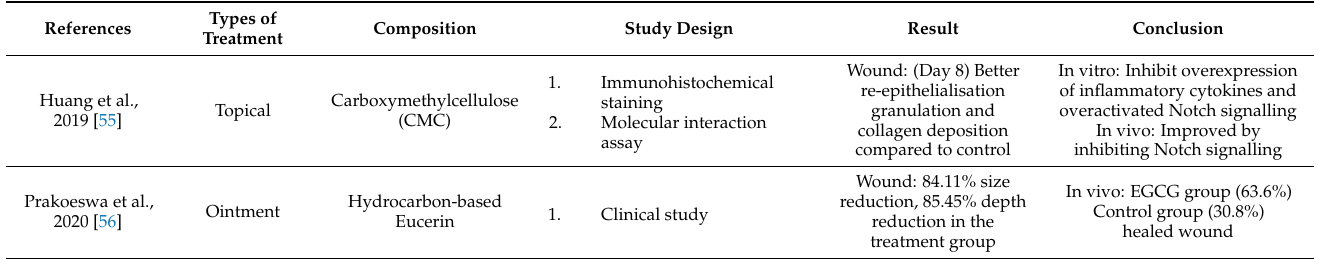
Table 3. Current study of EGCG incorporated treatment for wound healing.